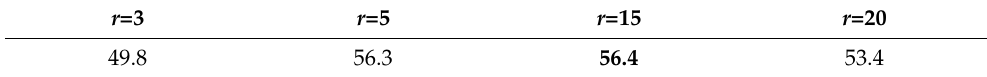
Table 7. Accuracy (%) of the number of recycling max pooling change experiments on M10 → S*10.